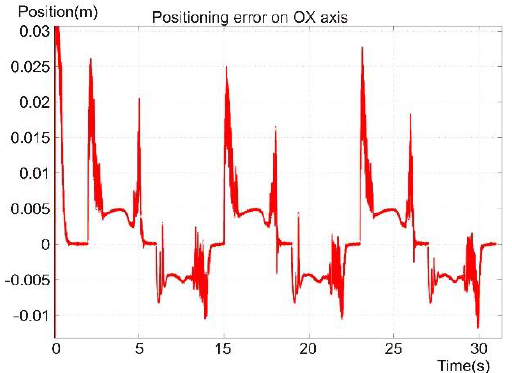
Figure 18. Foot positioning error on the OX axis.